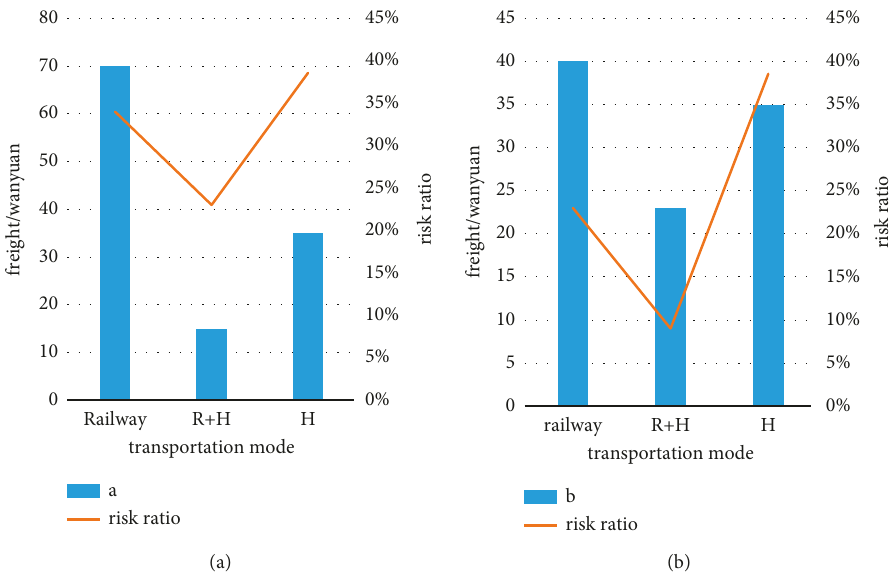
Figure 9: Optimal roadmap. (a) Route comparison of a demand place. (b) b demand place route